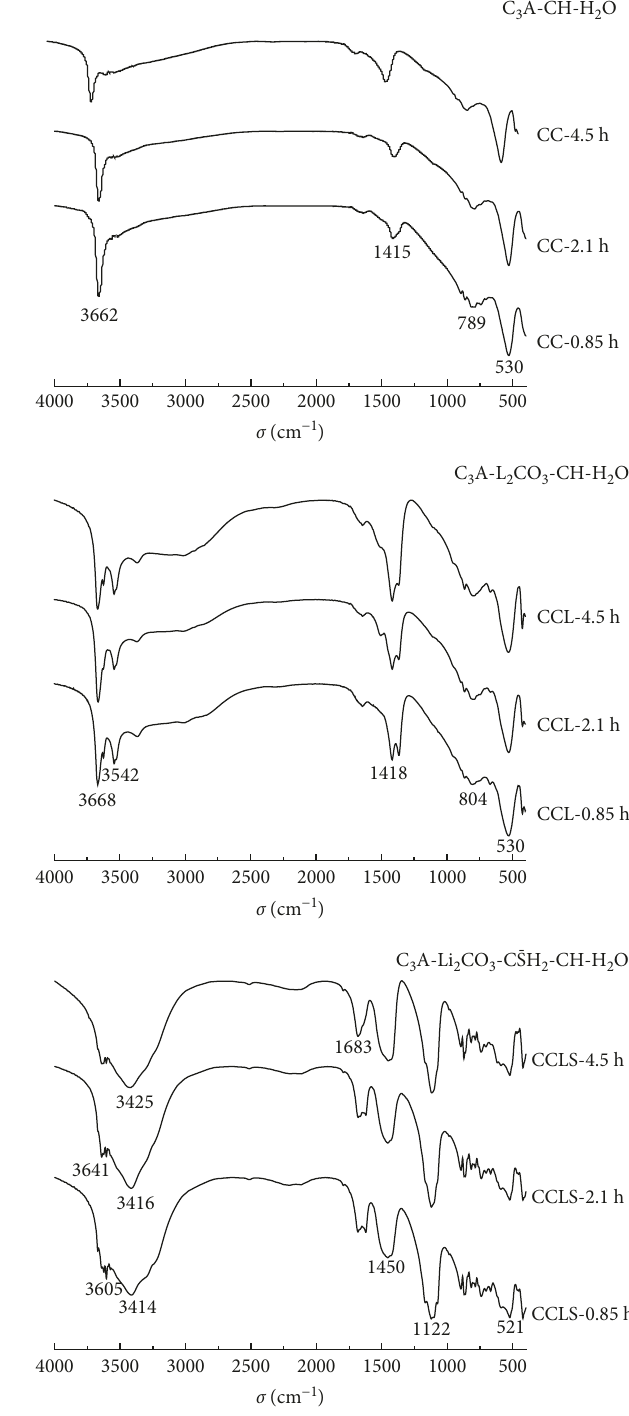
Figure 8: XRD patterns of three pastes (C1: C Figure 9: FTIR spectra of three 3 A; C2: C 3 AH 6 ; E: ettringite; Ms: monosulfoaluminate; G: gypsum; Mc: mono- carboaluminate; Hc: hemicarboaluminate; CH: calcium hydroxide).